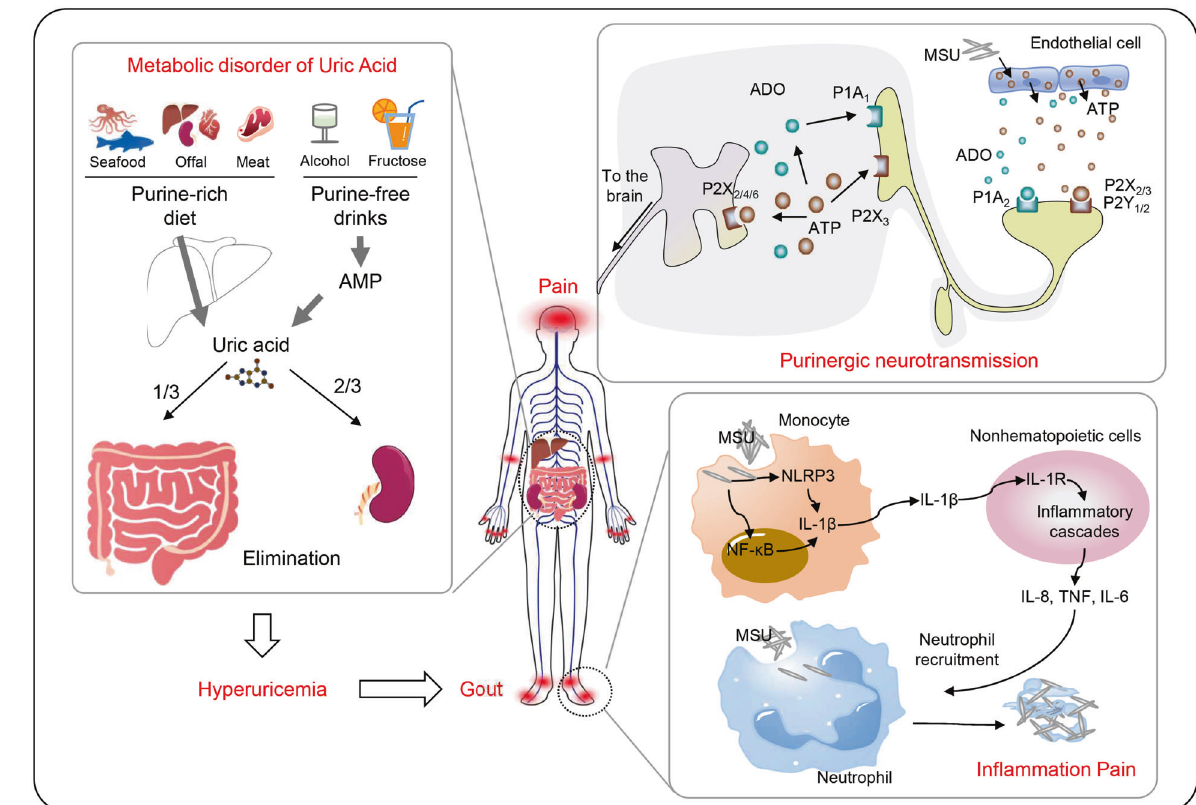
Fig. 3 Dysregulated purine metabolism contributes to gout and pain. Purine-rich diet and several beverages, including meat, seafood, animal offal, beer and fructose containing drinks, lead to high level of uric acid in vessel, termed hyperuricemia. Deposition of urate in joint induces local in fl ammation. In this process, adenosine (ADO) and ATP function as neurotransmitters to activate P1 and P2 purinergic receptors, respectively. This purinergic neurotransmission induces intense pain in gout